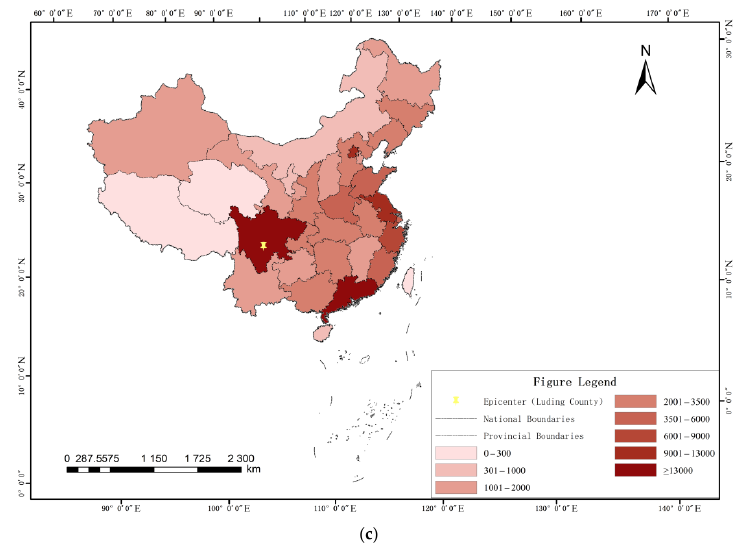
Figure 3. ( a ) Spatial sequence of microblogs posted after the Lushan earthquake, ( b ) spatial sequence of microblogs posted after the Maerkang earthquake, ( c ) spatial sequence of microblogs posted after the Luding earthquake.